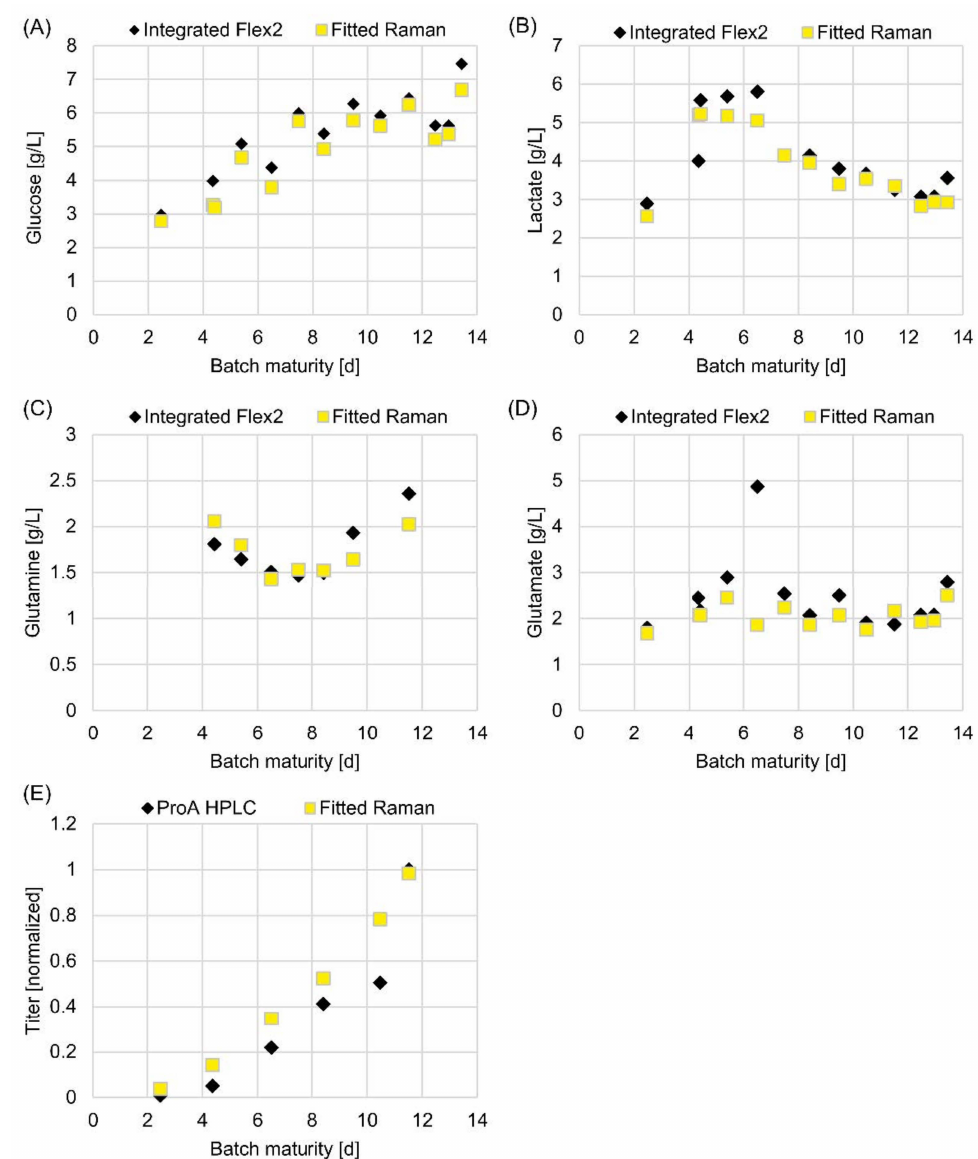
Figure 5. Observed vs. predicted development of analyte concentration during batch maturation. Comparison of observed (by reference method; black diamonds) and predicted (from the Raman spectroscopy models; yellow squares) analyte concentration vs. batch maturity from cell culture in a single 250 mL mini bioreactor; ( A ) glucose, ( B ) lactate, ( C ) glutamine, ( D ) glutamate, ( E ) mAb